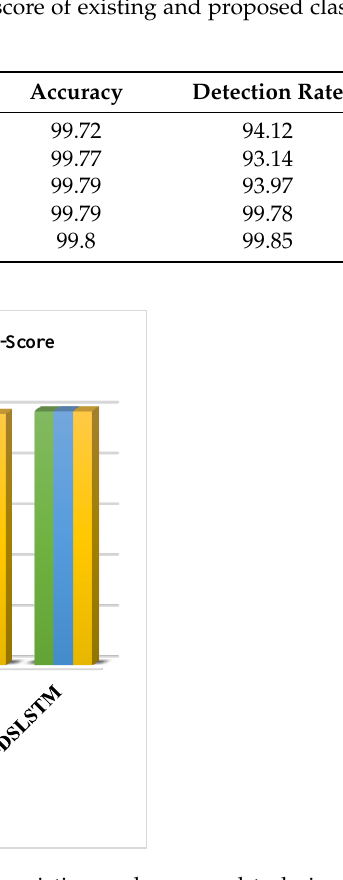
Figure 18. Comparative analysis between existing and proposed techniques using the SCADA network dataset. Table 6. Comparative analysis between the existing and proposed deep learning techniques based on FAR.